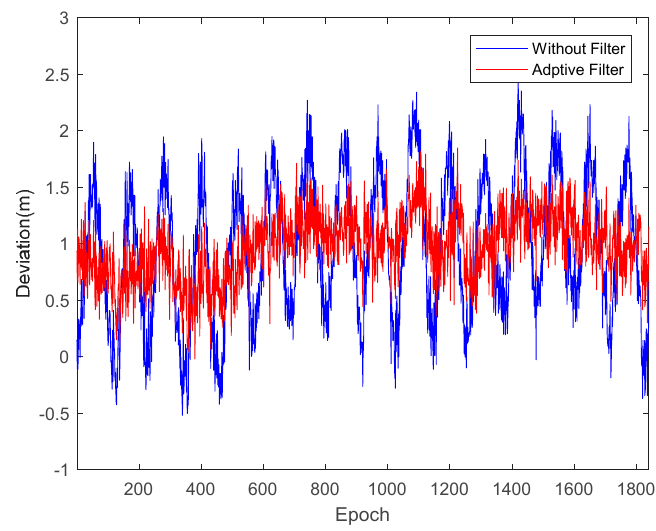
Figure 16. ( a ) CMCD (Time averaging, 100 epochs) in the time domain comparison before the adaptive frequency domain filter, C06, ( b ) CMCD (Time averaging, 100 epochs) in the time domain comparison after the adaptive frequency domain filter, C06.